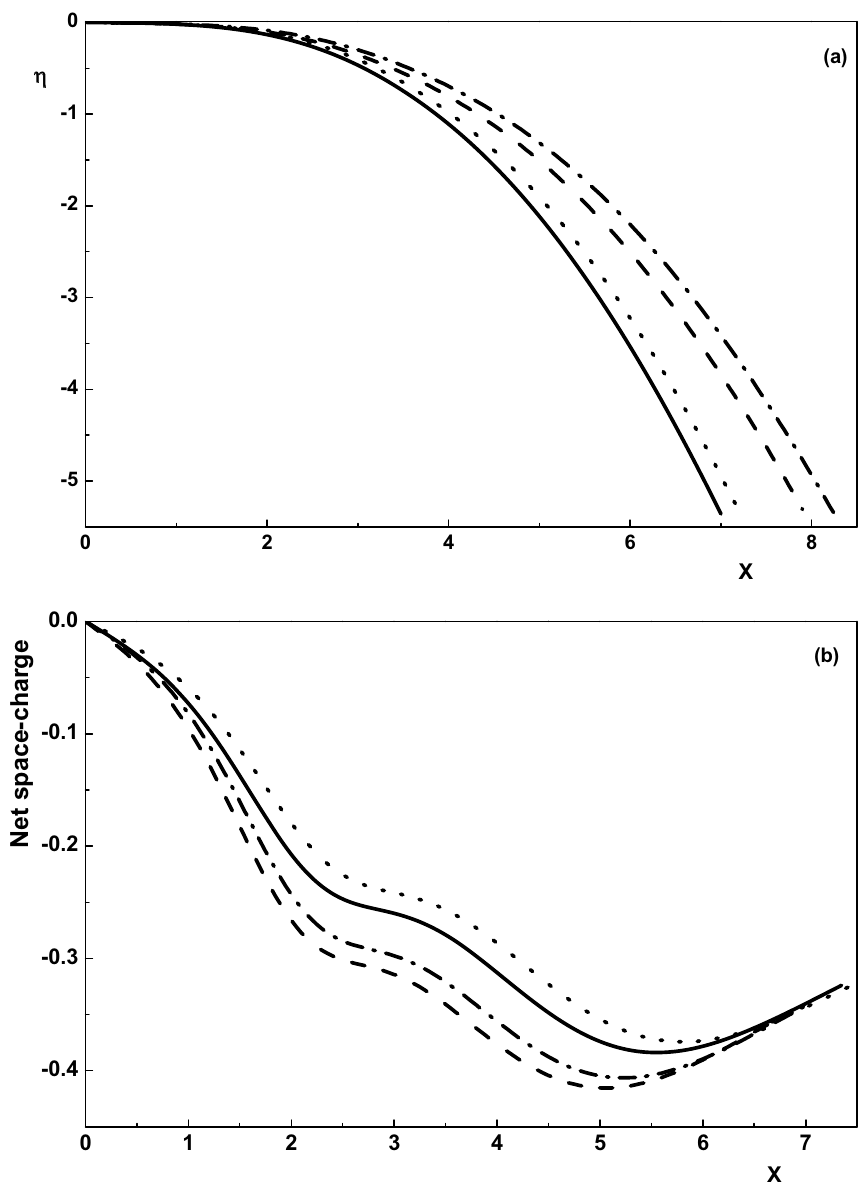
Figure 4. Variation of the normalized ( a ) electric potential and ( b ) net space-charge toward the wall for ν p 1 = 0, τ p 1 = 0 (dotted-dashed line), ν p 1 = 0, τ p 1 = 0.2 (dotted line), ν p 1 = 0.005, τ p 1 = 0 (dashed line) and ν p 1 = 0.005, τ p 1 = 0.2 (solid line). Other parameters are the same with Fig.